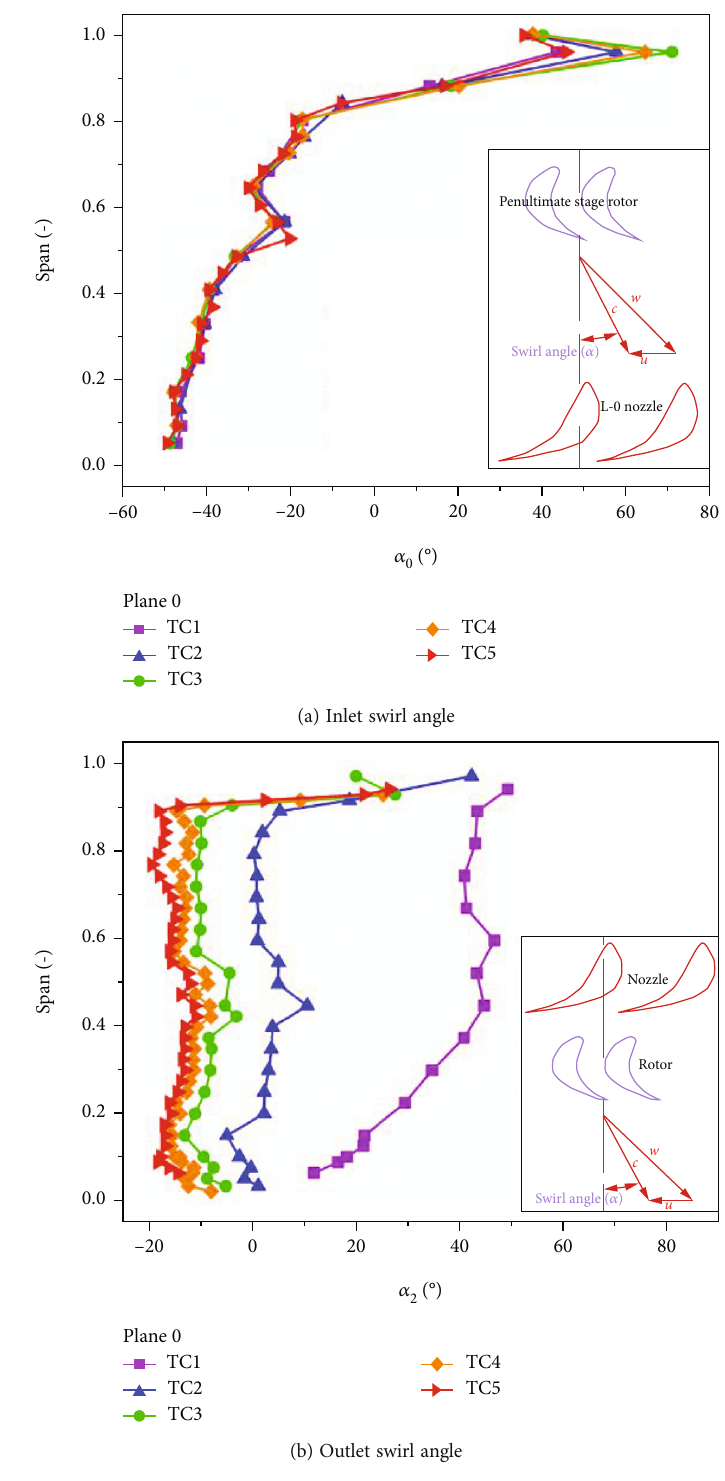
Figure 7: Swirl angle distribution of the L-0 inlet and outlet for all test